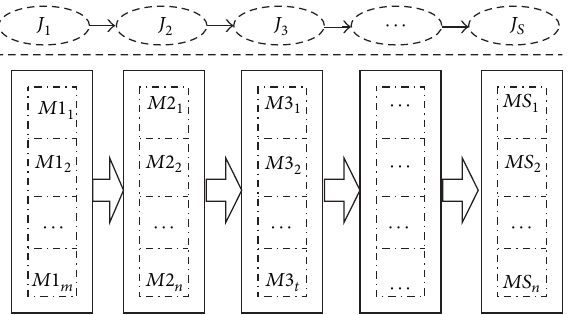
Figure 2: Distribution of engineering